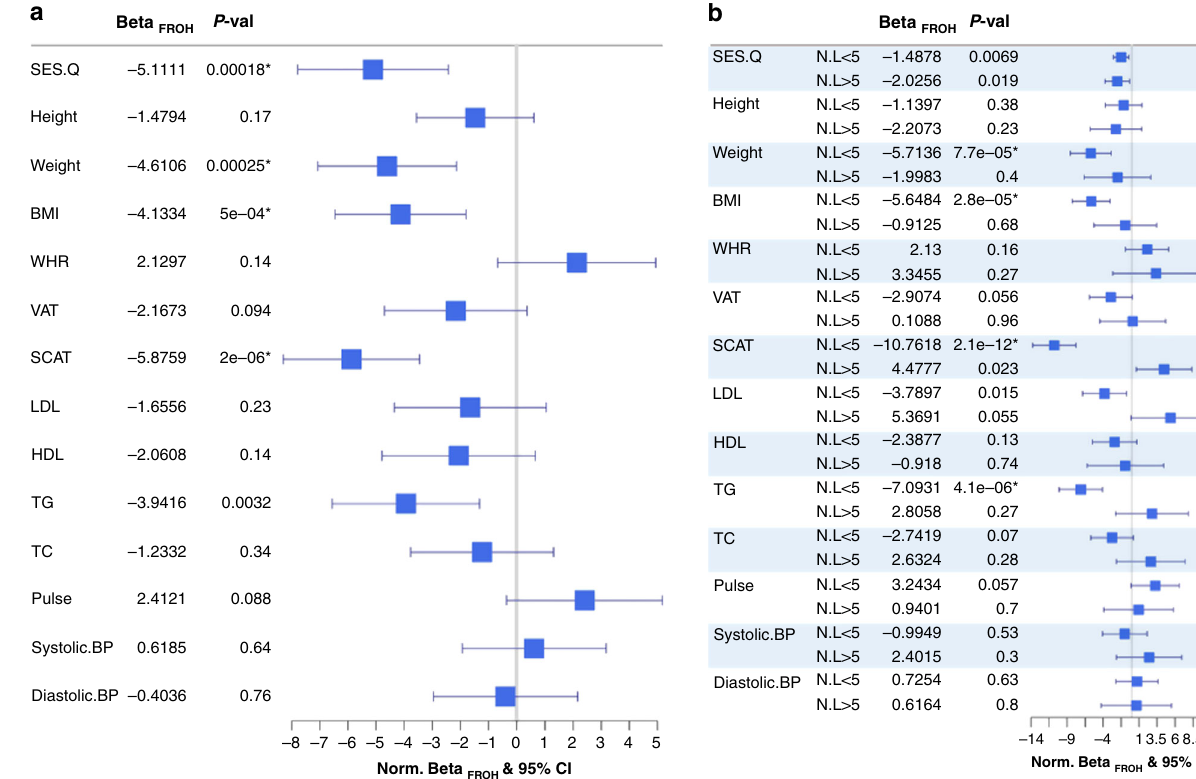
Fig. 2 Effect of inbreeding depression on cardiometabolic disease-associated traits in the AWI-Gen cohort. To allow comparison between traits, effects estimates ( β FROH ) and 95% con fi dence intervals are shown in units of within-group standard deviations. A regular Bonferroni correction for multiple testing was applied; signi fi cance is shown with an asterisk (0.05/14). a Normalized ( β FROH ) and 95% con fi dence intervals on 14 quantitative traits known to be cardiometabolic disease-associated traits: socio-economic status (SES.Q); six anthropometric traits, height, weight, body mass index (BMI), waist-to-hip ratio (WHR), visceral adipose tissue (VAT) and subcutaneous adipose tissue (SCAT); four classical blood lipids, high and low density lipoprotein cholesterol (HDL, LDL), total cholesterol (TC), and triglycerides (TG); and three circulatory traits, pulse rate, systolic blood pressure (Systolic BP) and diastolic blood pressure (Diastolic BP). Sample sizes, effect estimates in measurement units, standard deviations and p-values are shown in Table S1. b Differences in the effects of normalised ( β FROH ) and 95% con fi dence intervals between sites with an average night-light intensity below and above 5. Sample sizes, effect estimates in measurement units, standard deviations and p -values for dwellers living in sites with average night-light intensity below and above 5 are shown in Tables S2 and S3